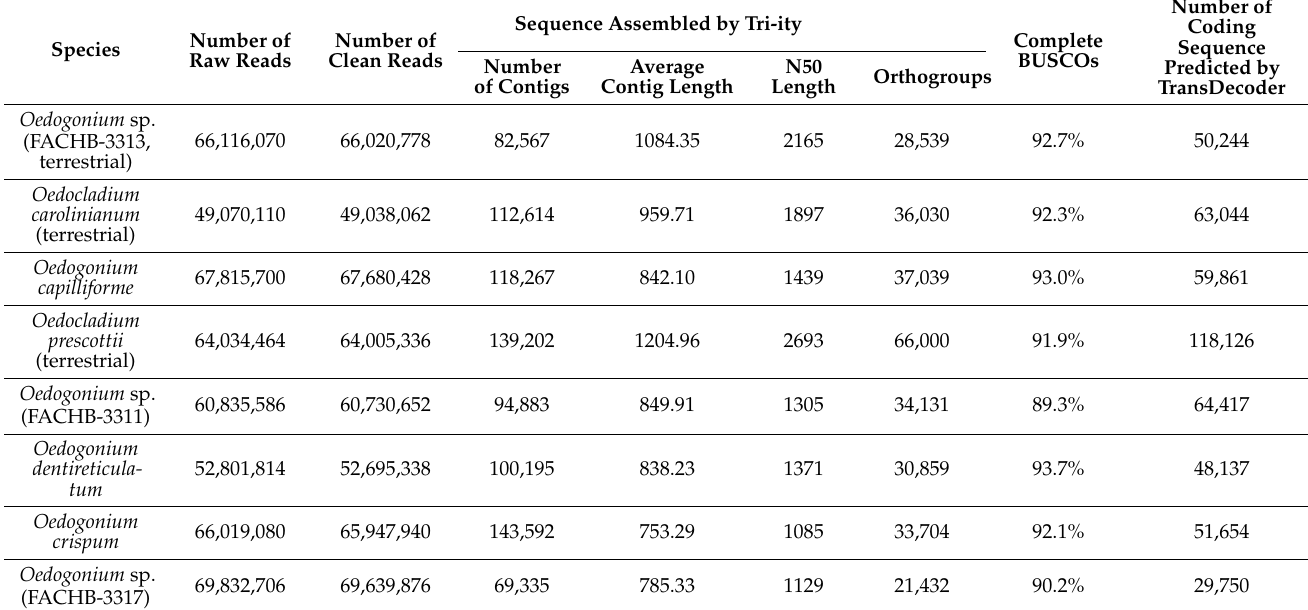
Table 1. Summary of sequencing and